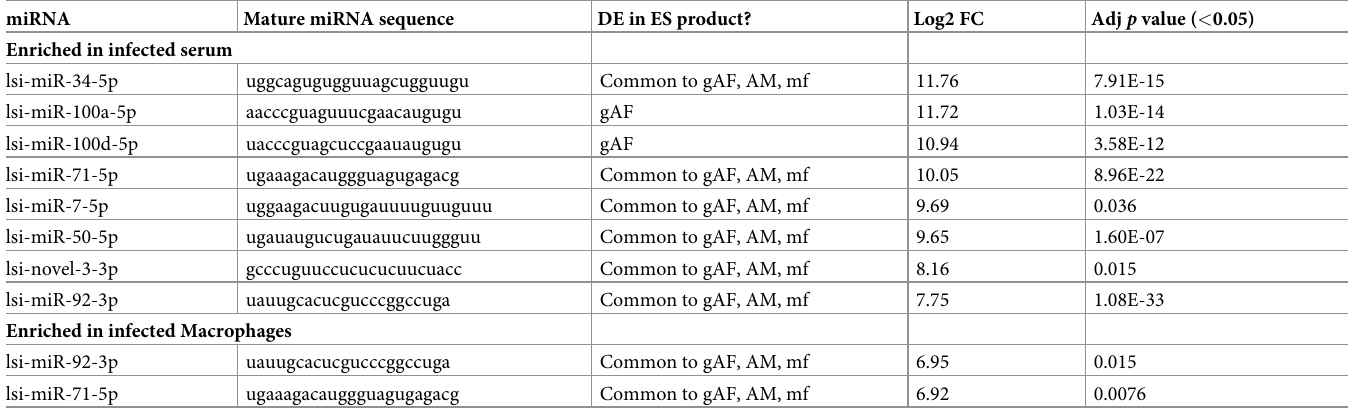
Table 4. Differentially abundant parasite-derived miRNAs in serum and macrophages from na ï ve vs infected jirds. miRNA Mature miRNA sequence DE in ES product? Log2 FC Adj p value ( <